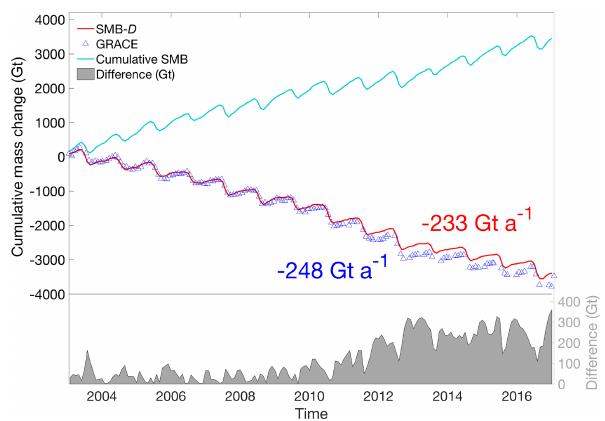
Figure 2. Comparative cumulative GrIS mass change relative to 2003 between GRACE and monthly SMB − D . Cumulative SMB is also plotted, with cumulative differences among estimates plotted at the bottom of the panel, associated with the right y